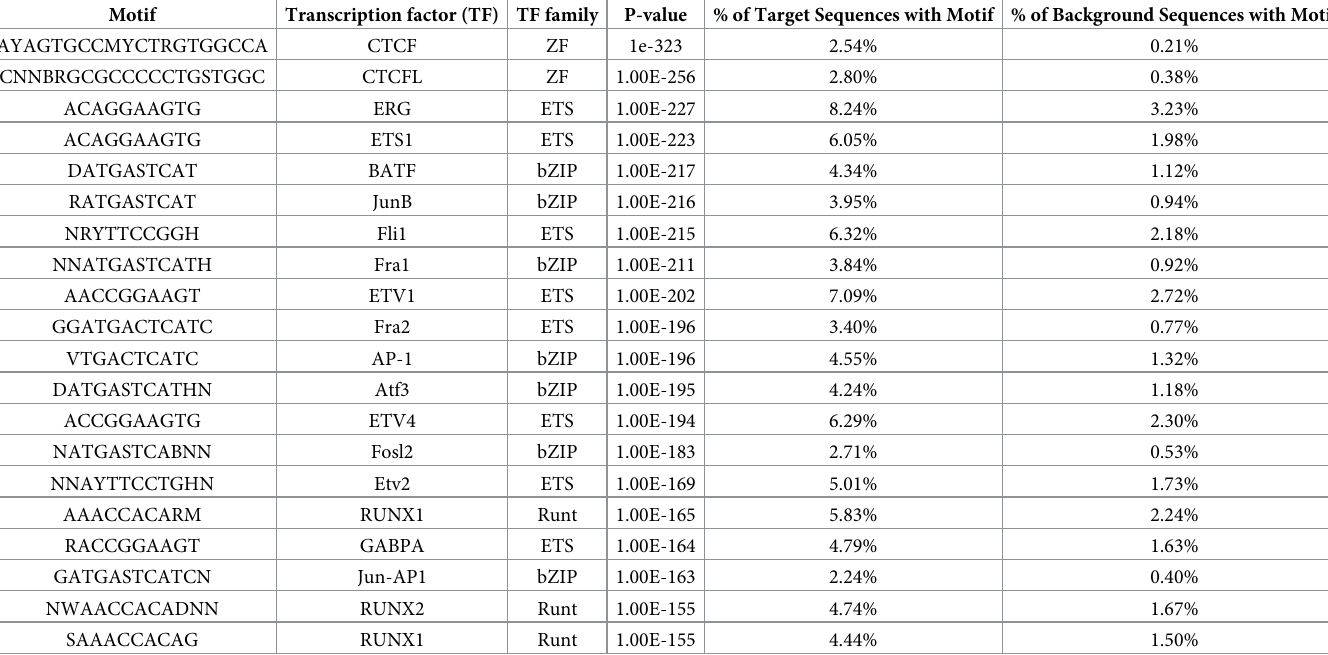
HOMER motif enrichment analysis of all differentially open/closed peaks between GFP+ and GFP- infected cells, using the whole human genome as a reference baseline. The 20 most enriched sequences and the putative TFs that bind these sequences are